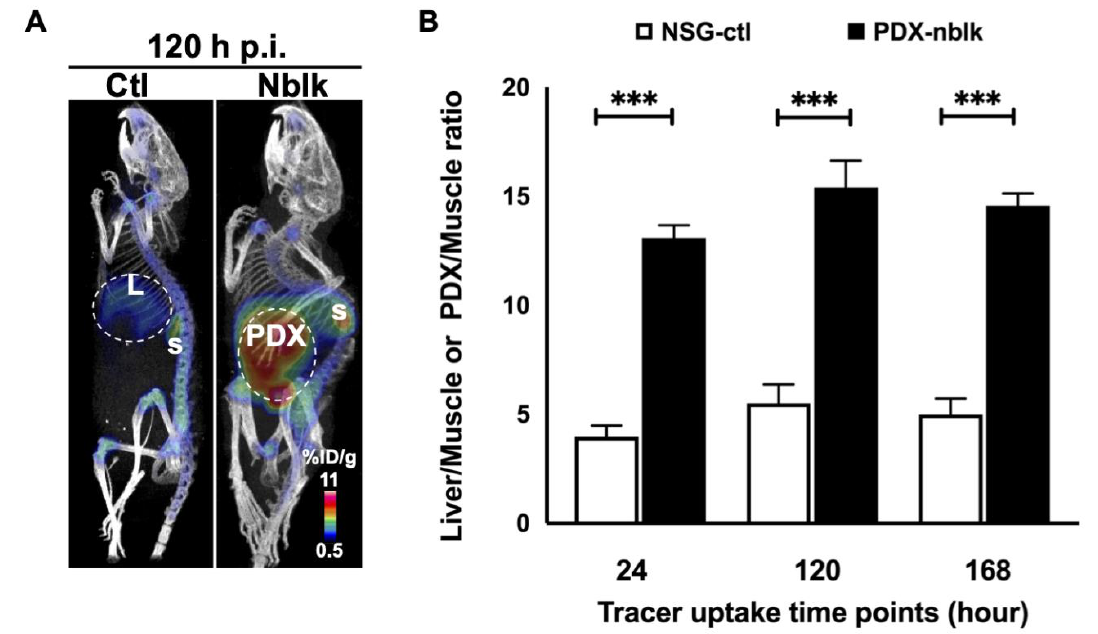
Figure 4. PET/CT images at 120 h p.i. of 89 Zr-Df-H3K3 and Ctl liver-to-muscle or PDX-to-muscle ratios. ( A ) PET/CT images of orthotopic HCC PDX at 120 h p.i. showed marked accumulation of 89 Zr-Df-H3K3 in the PDX of the non-blocking group compared with the non-tumor bearing liver (L) of the control group. S = Spleen ( B ) Ctl liver-to-muscle or PDX-to-muscle ratios at various time points (24, 120, and 168 h p.i.) of 89 Zr-Df-H3K3. Data were computed as mean ± SD %ID/g ( n = 4) from ROI of non-tumor bearing liver from control group, and of the PDX tissues in the non-blocking PDX group. *** p = 0.001